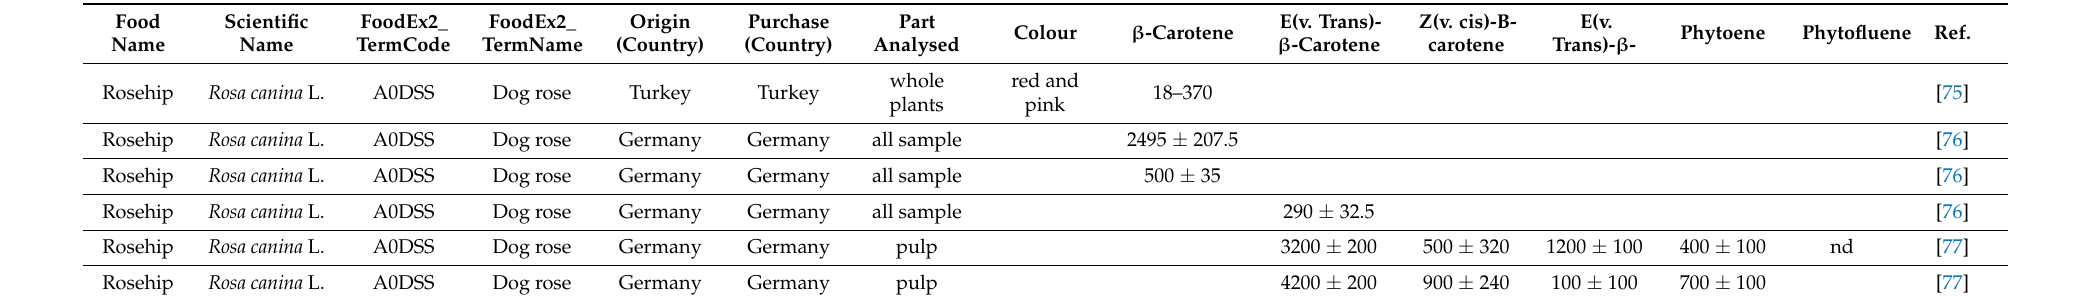
Table A6. Rose hips and similar (A01FR) ( µ g/100 g).